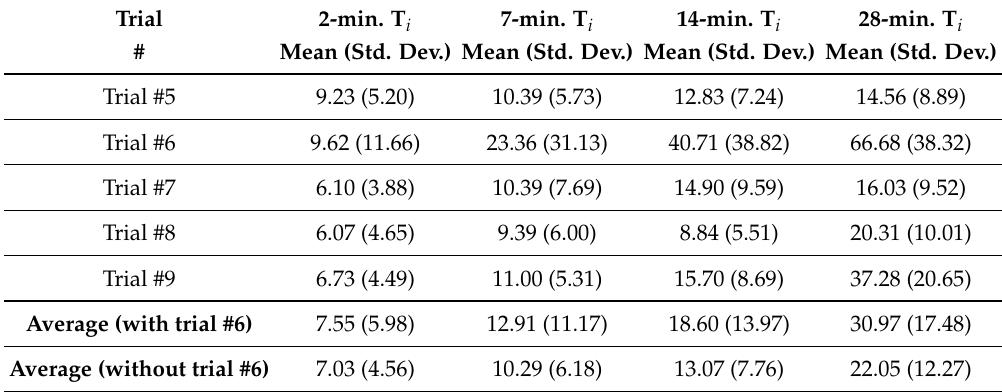
Table 12. Test Set: L 2 Position Errors (cm) for Configuration C ψ , z using Est. Speed & Est. Heading.